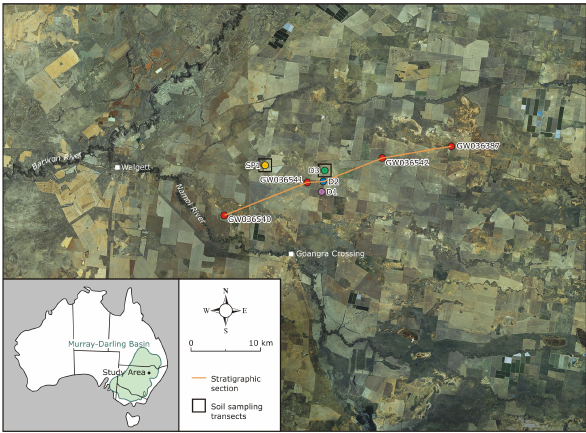
Fig. 1. Location map, showing the Namoi River, groundwater monitoring sites and location of stratigraphic section (Google earth